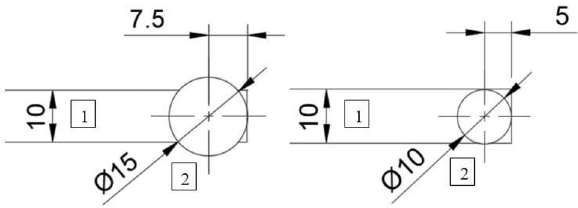
Figure 3. Botton view of a sample with position of both types of piezo trandsucers used: 1: sample, 2: piezo transducer; left: KingState KPE-827, right: PI P-010.00P; sizes are in mm.